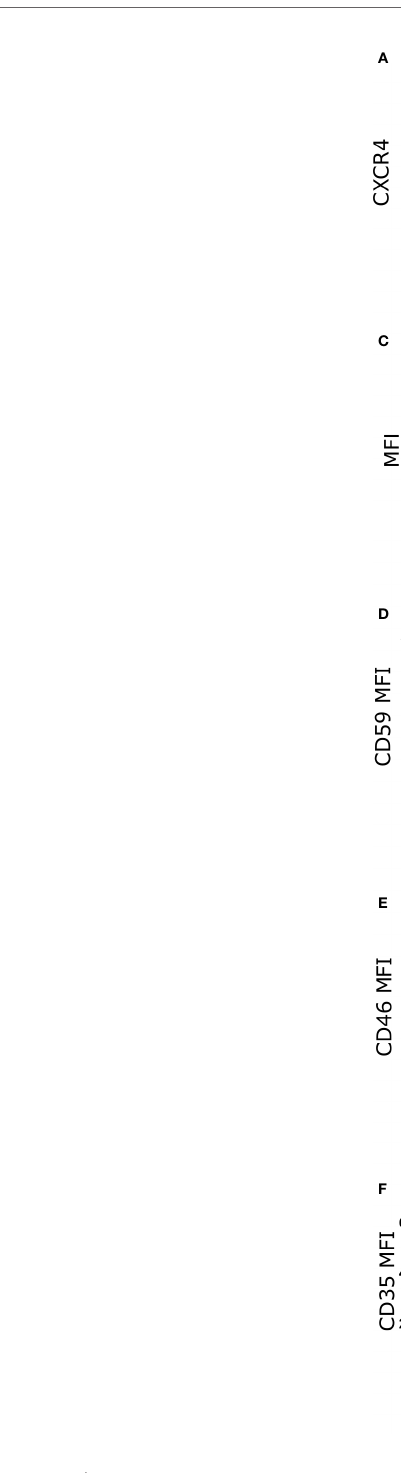
FIGURE 4 | DAF expression on DZ and LZ B cells. (A) Representative gating strategy for light zone (LZ, CD83 + CXCR4 − ) and dark zone (DZ, CD83 − CXCR4 + ) of CD19 + CD20 + CD38 + IgD − B cells. (B) Frequency of DAF hi cells within the total GC B cell population and on LZ and DZ GC B cells. Bars represent median with interquartile range. *P < 0,05 by Wilcoxon signed-rank test. (C) Expression of CD59, CD35, and CD21 on DAF hi or DAF lo GC B cells in DZ (left) or LZ (right). (D) Expression of CD59, (E) CD46, and (F) CD35 on resting, unswitched activated (Unsw act), DAF hi or DAF lo GC B cells, and memory B cells (left), and plasmablasts (PB) and plasma cells (PC) (right). Median fl uorescence intensity (MFI) is represented as individual dots where lines indicate median with interquartile range. Data was acquired from multiple patients (n = 6). Bars represent median with interquartile range. *P < 0.05 by Wilcoxon signed-rank